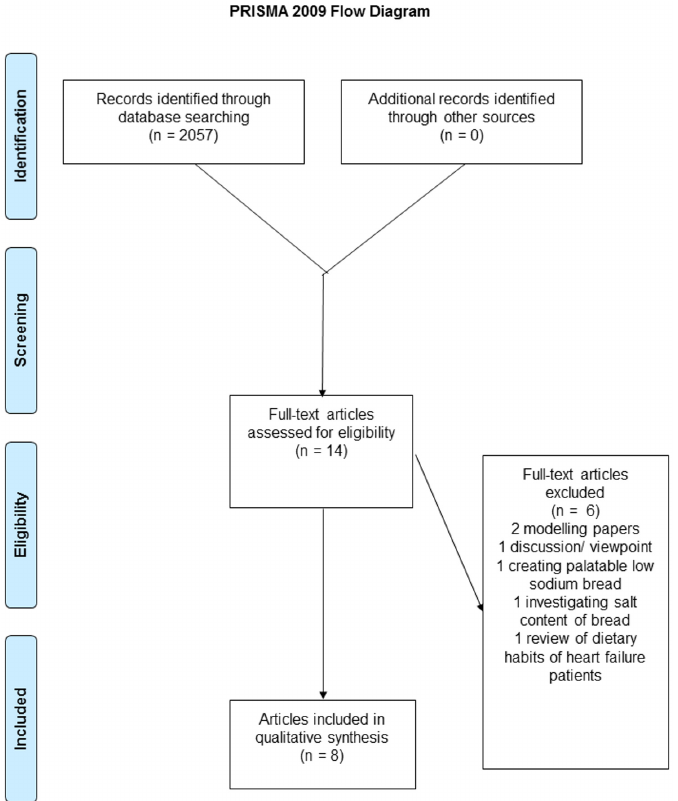
Fig 1. PRISMA Flow Diagram showing inclusion and exclusion of identified papers. From : Moher D, Liberati A, Tetzlaff J, Altman DG, The PRISMA Group (2009). P referred R eporting I tems for Systematic Reviews and M eta- A nalyses: The PRISMA Statement. PLos Med 6(6): e1000097. doi: 10.1371/journal. pmed1000097 For more information, visit